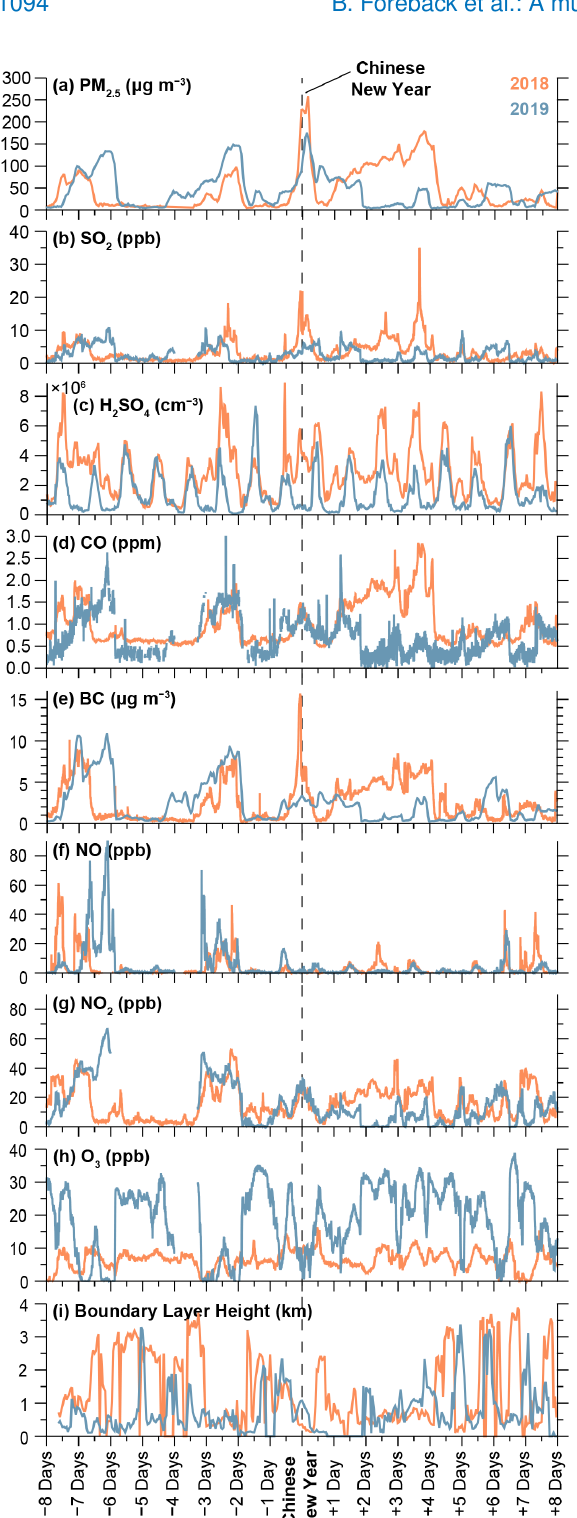
Figure 2. Concentrations of main pollutants measured and bound- ary layer height in Beijing during the 2018 CNY (orange) and 2019 CNY